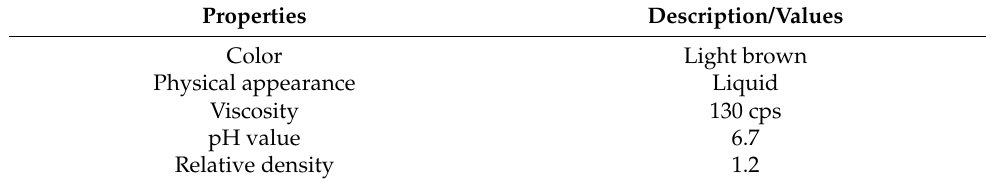
Table 3. Properties of used